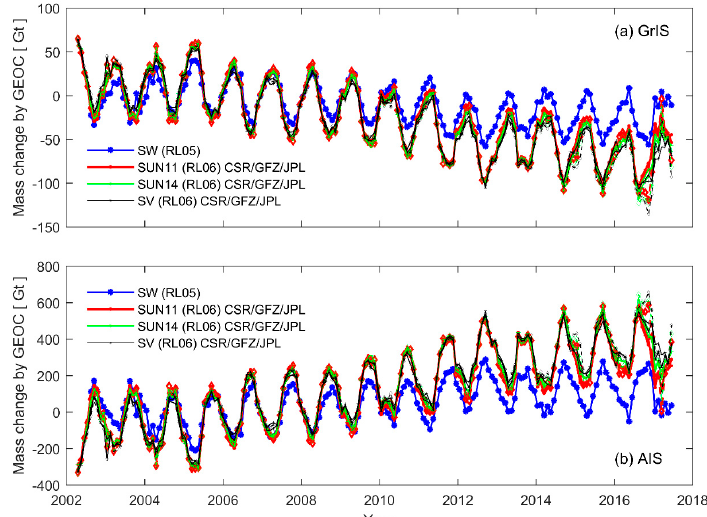
Figure 2. Time series of mass change caused by degree one terms (geocenter motion, GEOC) over ( a ) the GrIS and ( b ) the AIS, respectively, using degree one terms corresponding to GRACE RL05 and RL06 data published by each data processing center. CSR/GFZ/JPL indicates that the time series of mass change caused by degree one terms are calculated separately and are shown for GRACE data published by the Center for Space Research (CSR), Deutsches GeoForschungsZentrum (GFZ), and Jet Propulsion Laboratory (JPL). Table 2. The linear trend and annual amplitude (Amp.) of mass change time series caused by GEOC or degree one terms over the GrIS and the AIS during the time span from August 2002 to July 2016, using degree one terms corresponding to GRACE RL05 and RL06 data published by CSR, GFZ, and JPL.